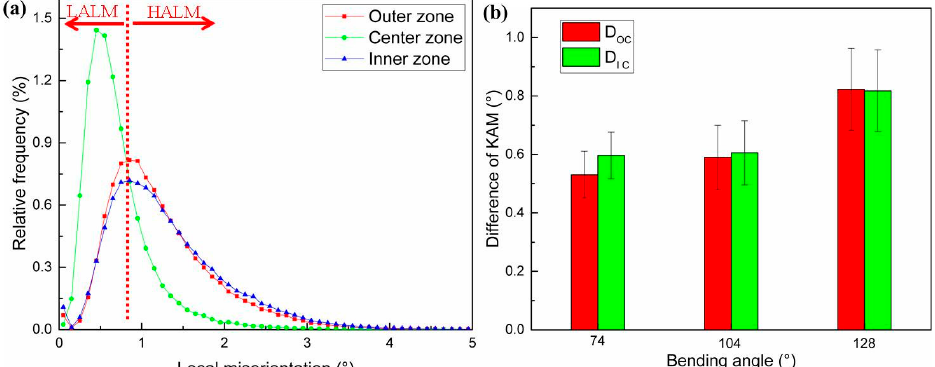
Figure 5. Change in the local misorientation and the difference in kernel average misorientation (KAM). ( a ) Change in the local misorientation of bending specimen at 74° angle; ( b ) Difference in kernel average misorientation in specimens strained at different bending angles.